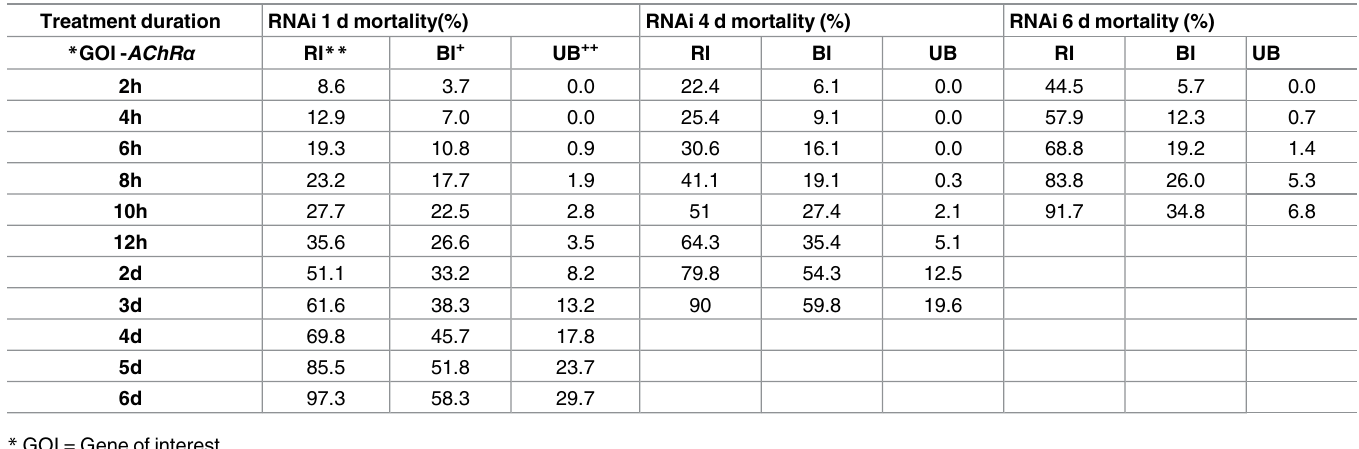
Table 4. Percent mortality post- AChR α dsRNA knock down, and exposure to I MaxxPro ® & . Treatment duration RNAi 1 d mortality(%) RNAi 4 d mortality